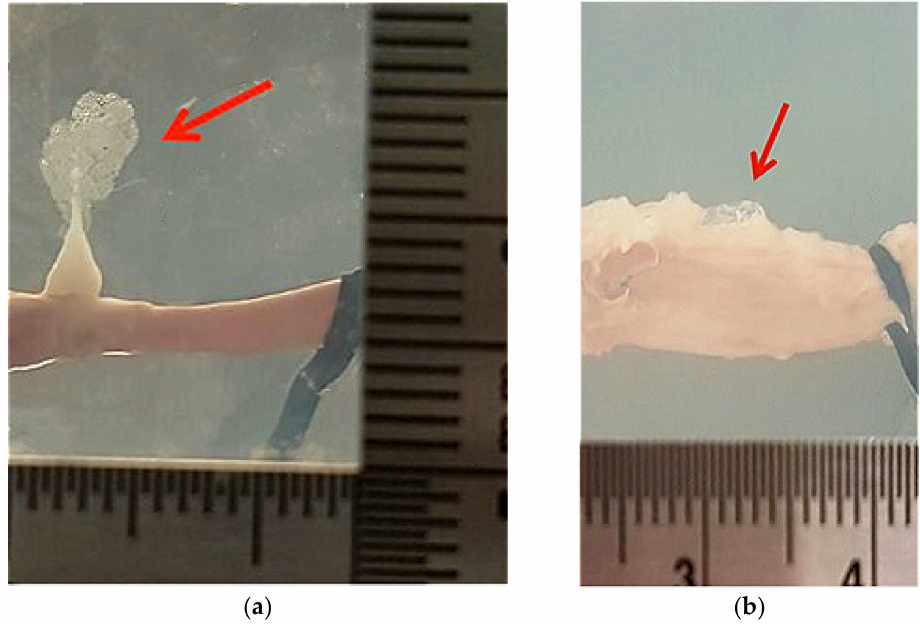
Figure 8. Abnormal phenomena of ( a ) lesion in a shape of a “squid” with a slim structure in the lesion tail and ( b ) large residual bubble on the artery without lesion surrounding it found after HIFU